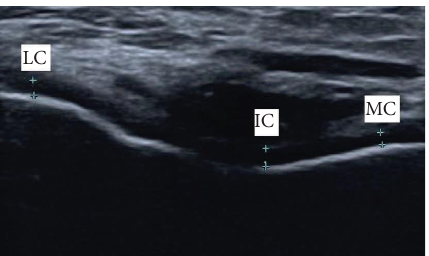
Figure 1: Transversal ultrasound suprapatellar scan of the knee joint in right femoral cartilage; lateral condyle (LC), intercondylar (IC), and medial condyle (MC).